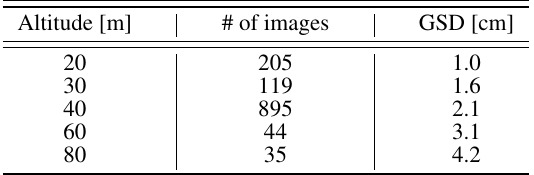
Figure 1. Study area: Arno river in the locality of Prulli (Italy).